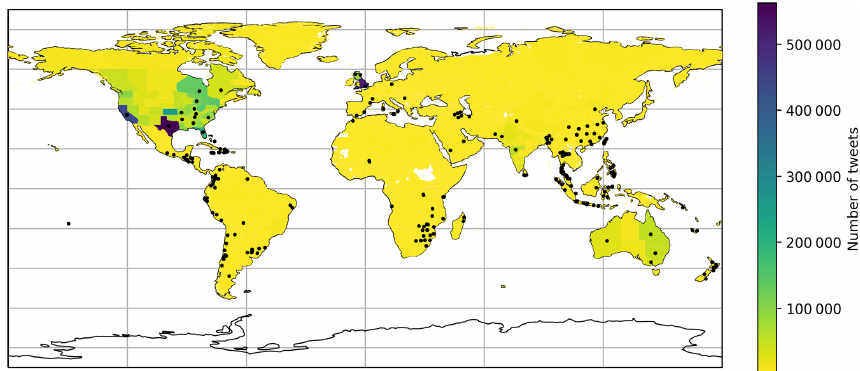
Figure 2. Global map showing the number of filtered heavy rainfall tweets located in each GADM level 1 administrative area during the period of study (1 January–30 June 2017). Areas with white shading had no located tweets during the period of study; shaded areas had at least one tweet. Locations of impact events recorded in the Met Office database are shown by black